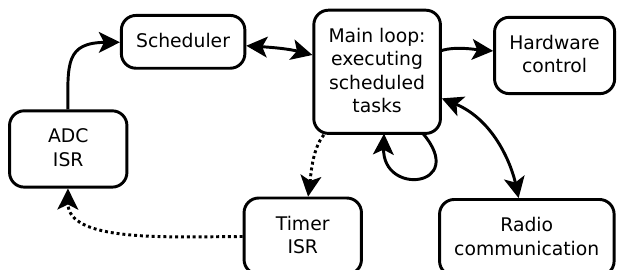
Figure 4. Firmware block diagram of the PCARD sensor. Full lines represent direct connections, while dotted lines represent indirect influence.